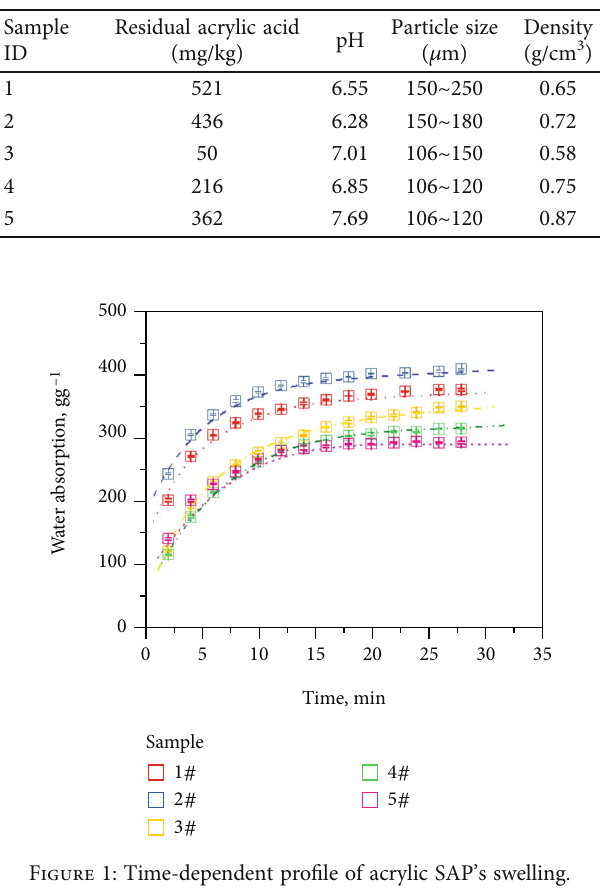
Table 1: The information of acrylic SAPs.